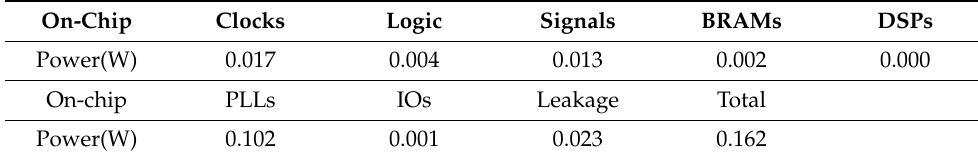
Table 2. Power consumption of each system part.